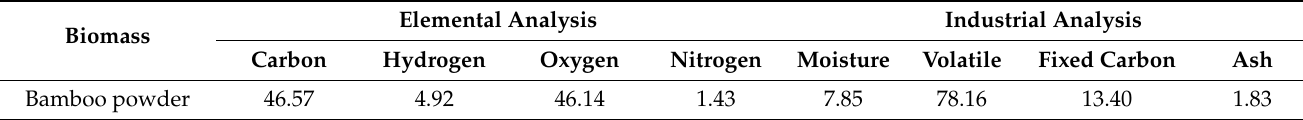
Table 2. The performance of bamboo powder (wt%).